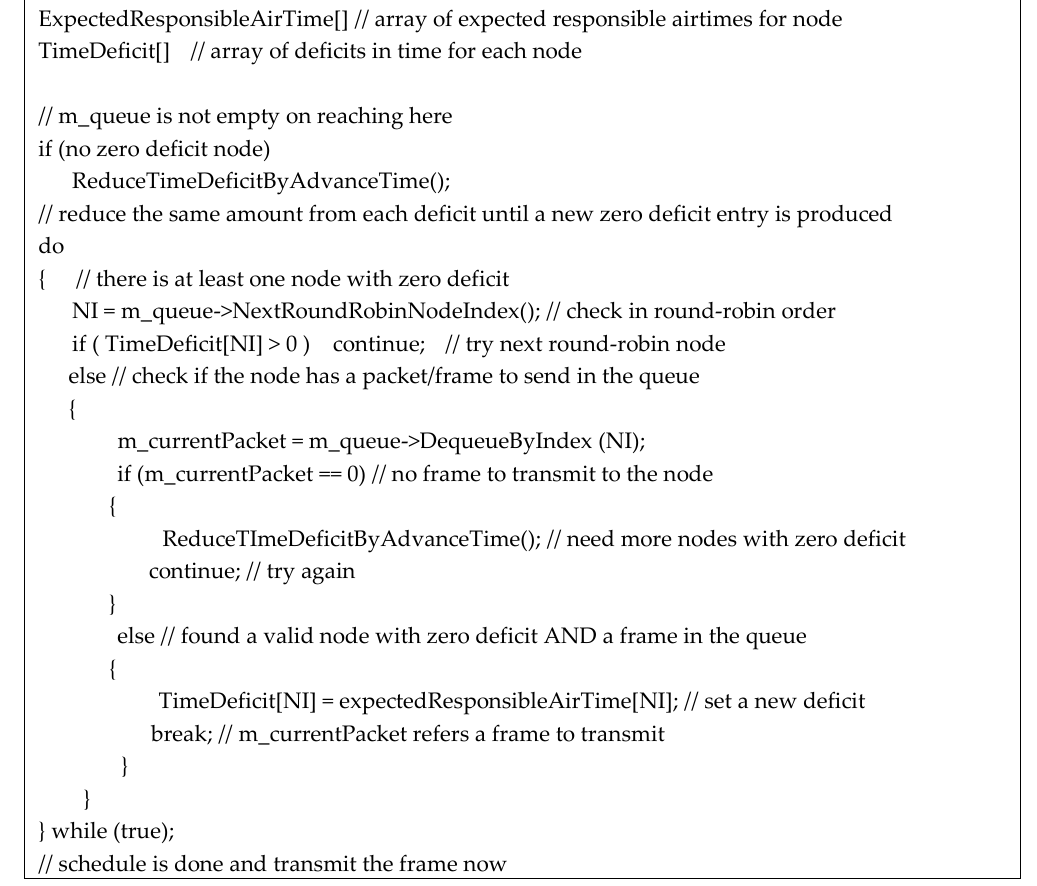
Figure 3. Code Segment of Responsible Airtime Fair Scheduling.